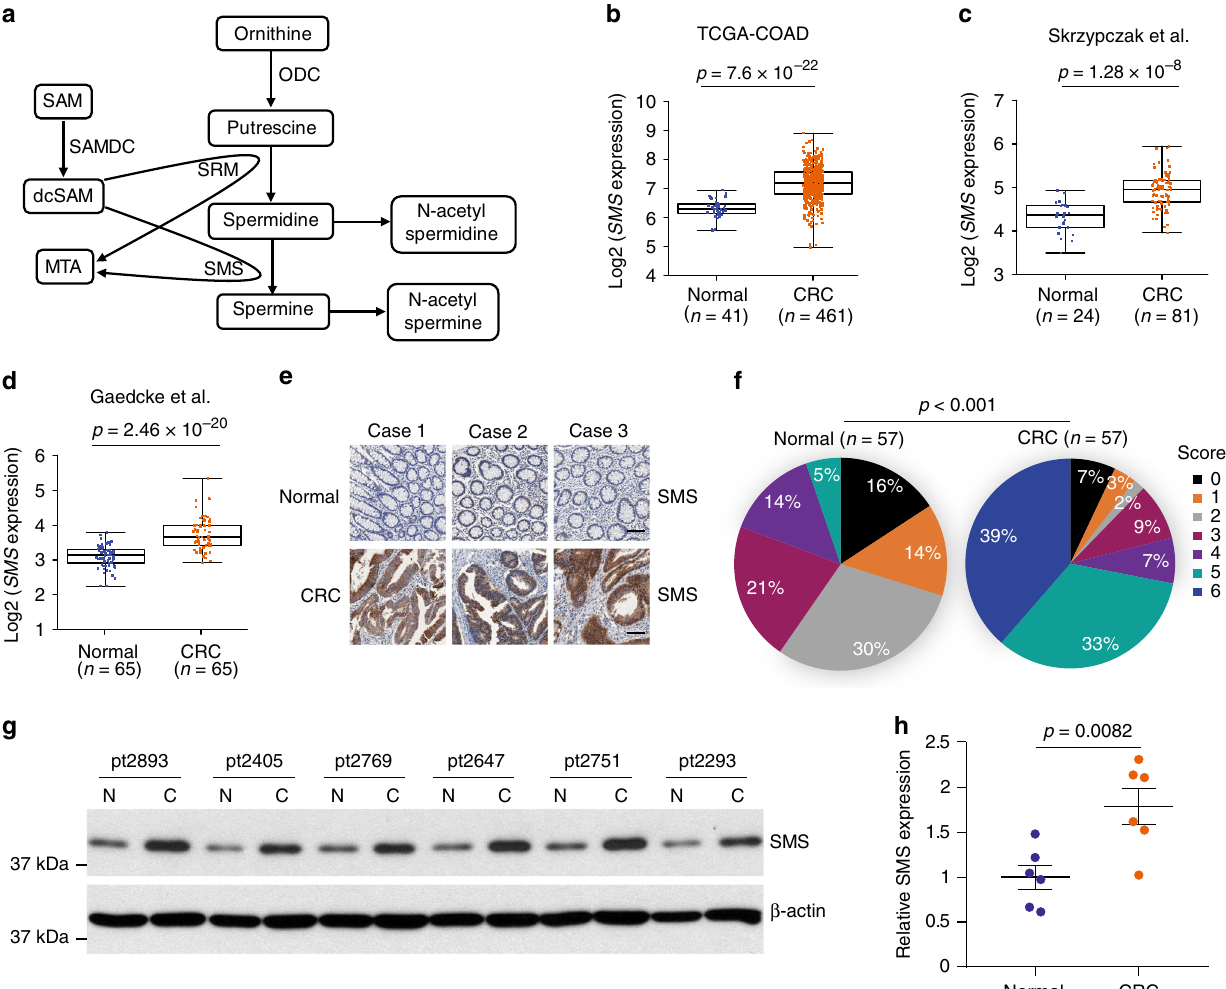
Fig. 1 SMS is overexpressed in CRC. a Schematics of polyamine metabolism pathway. ODC ornithine decarboxylase, SRM spermidine synthase, SMS spermine synthase, SAMDC S -adenosylmethionine decarboxylase, SAM S -adenosylmethionine, dcSAM decarboxylated S -adenosylmethionine, MTA 5 ′ - methylthioadenosine. b – d The mRNA expression levels of SMS were analyzed from three different datasets of human CRC specimens. Statistical signi fi cance between CRC tissues and normal controls was determined by the linear mixed model in b and d , or two-tailed two-sample t test in c , with the p -values indicated. e , f A tissue microarray containing 57 pairs of human CRC tumor and adjacent normal control tissues was subjected to IHC staining for SMS. Representative staining images are shown in e , and the percentages of the immunoreactivity scores are summarized in a diagram ( f ). Statistical signi fi cance was determined by the χ 2 -test with the p -value indicated. Scale bar, 100 µ m. g , h Matched normal and tumor tissues from six patients with CRC were analyzed for SMS expression using western blot analysis ( g ). The expression of SMS protein was quanti fi ed by normalizing to β -actin using Image J. The relative SMS levels in tumor tissues ( h ) were compared with that of normal tissues within the same patient. The data are presented as mean values ±SEM ( n = 6 biologically independent samples). The p -value by two-tailed unpaired t test is indicated. Source data are provided as a Source Data fi